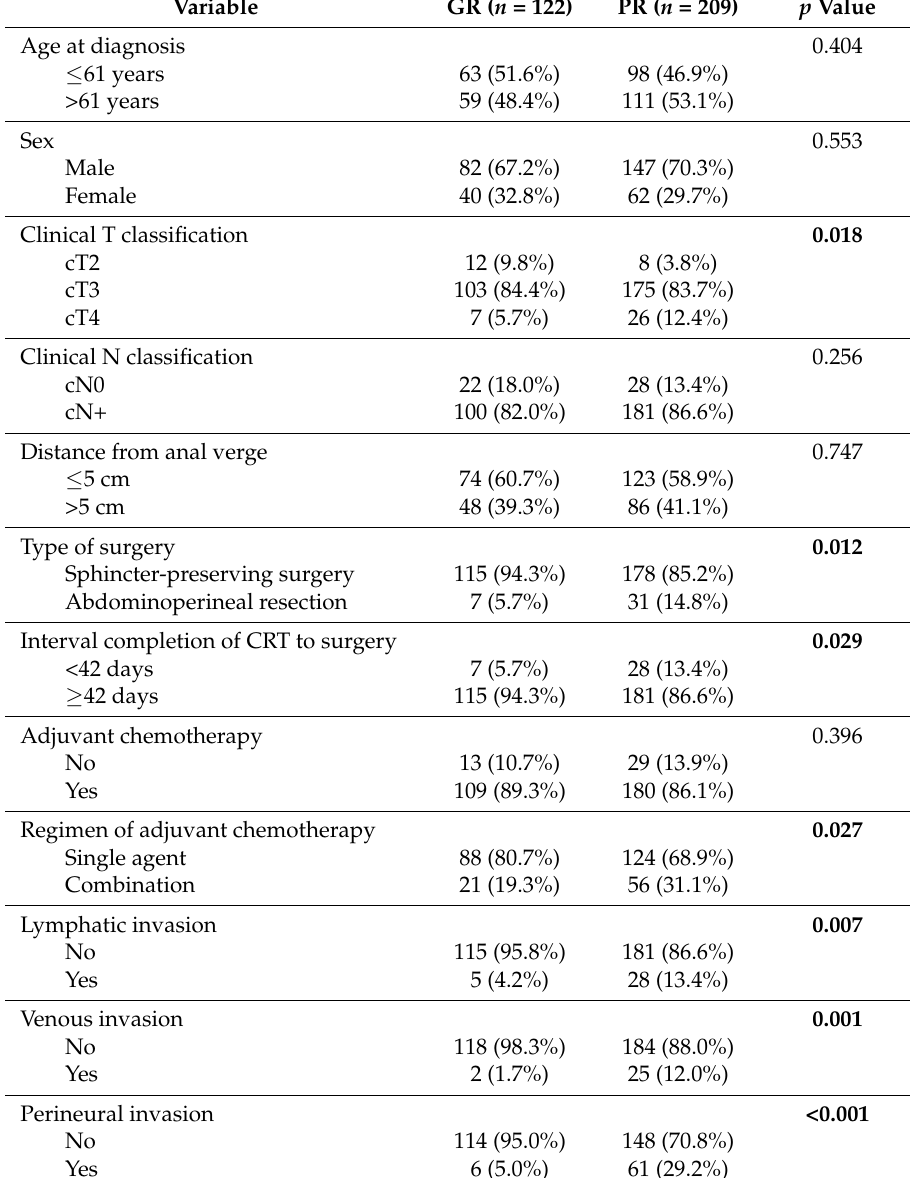
Table 1. Clinicopathologic characteristics of patients with a good response (GR, TRG 3/4) and poor response (PR, TRG